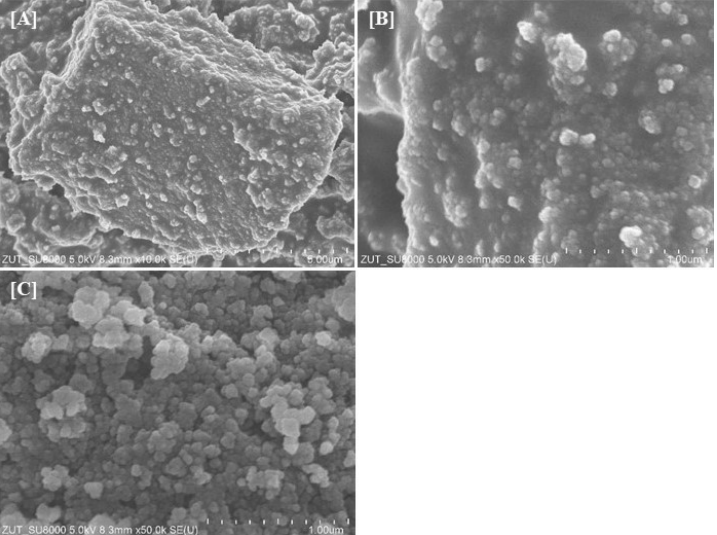
Figure 5. SEM images taken for ( A , B ) starting TiO 2 captured at different magnifications and ( C ) SiO 2 (14.3%)/TiO 2 _400. ( C ) SiO 2 (14.3%)/TiO 2 _400.